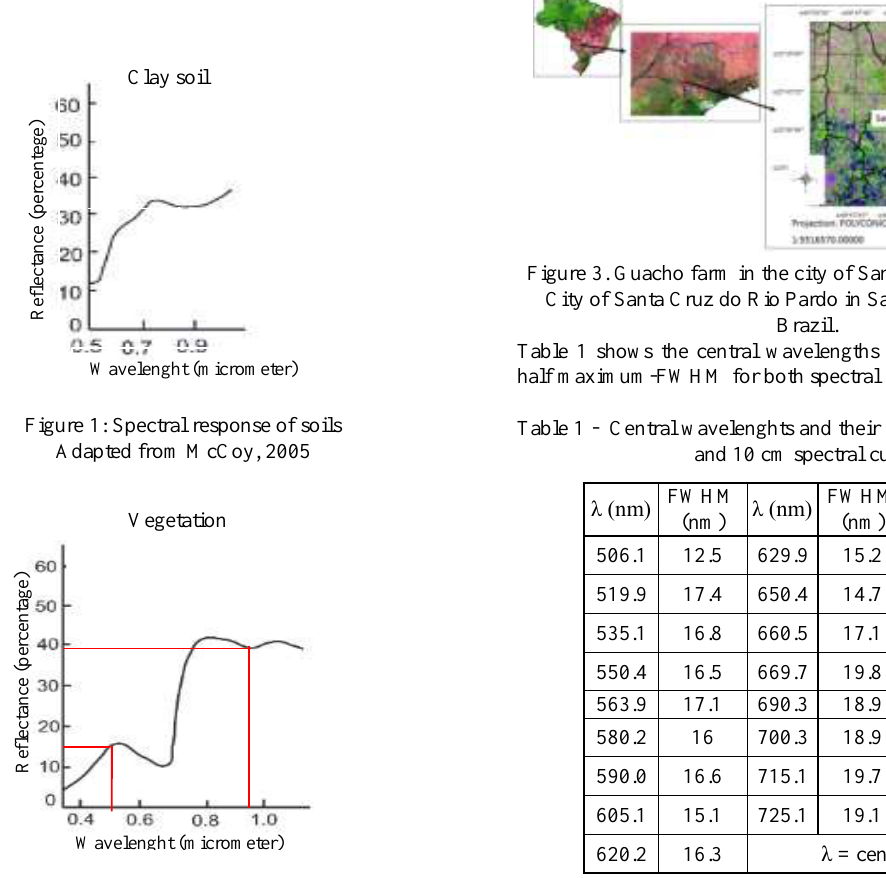
Figure 2: Spectral response of vegetation Adapted from McCoy, 2005